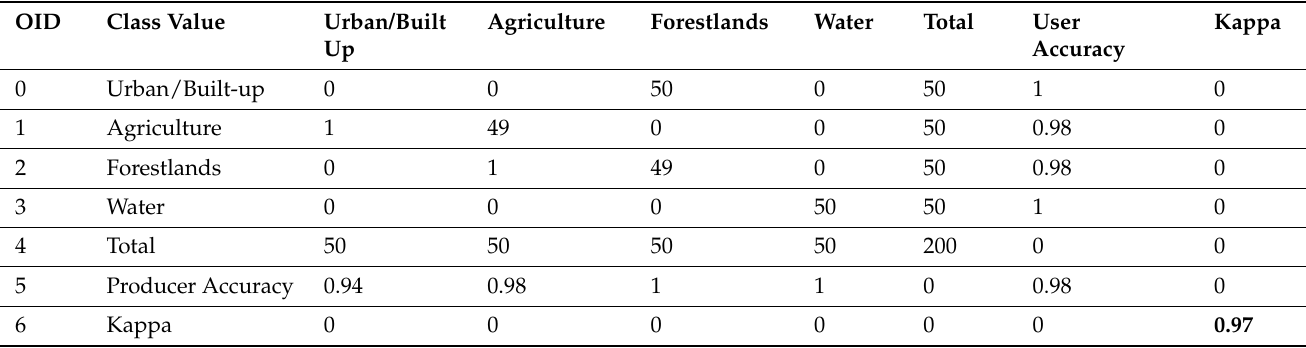
Table A2. User, Producer, and Kappa statistics for the classified image of 2003.